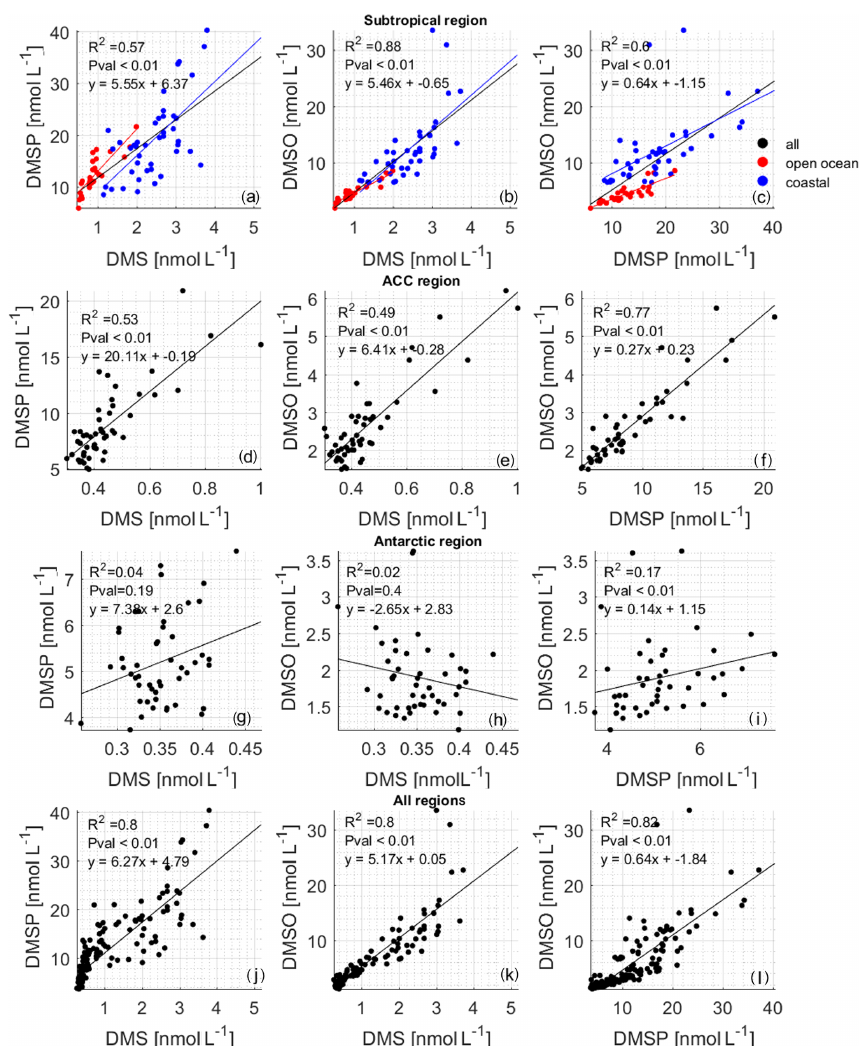
Figure 6. Correlations between measured DMSP and DMS (the left column of the figure), DMSO and DMS (the middle column of the figure), and DMSO and DMSP (the right column of the figure): (a–c) subtropical region (black points), (d–f) ACC region, (g–i) Antarctic region, and (j–l) entire cruise. The red points in (a) – (c) are data from the open ocean in the subtropical area, and the blue points are data from the subtropical area near the coast. The results of the correlation analysis between DMS and DMSP are R 2 = 0.81, p < 0.01, y = 8 . 14 x + 5 . 01 for open-ocean waters and R 2 = 0.38, p < 0.01, y = 7 . 13 x + 1 . 9 for coastal waters. The results of the correlation analysis between DMS and DMSO are R 2 = 0.77, p < 0.01, y = 3 . 61 x + 1 . 12 for open-ocean waters and R 2 = 0.61, p < 0.01, y = 6 . 02 x − 2 . 04 for coastal waters. The results of the correlation analysis between DMSP and DMSO are R 2 = 0.76, p < 0.01, y = 0 . 37 x − 0 . 11 for open-ocean waters and R 2 = 0.5, p < 0.01, y = 0 . 49 x + 3 . 26 for coastal